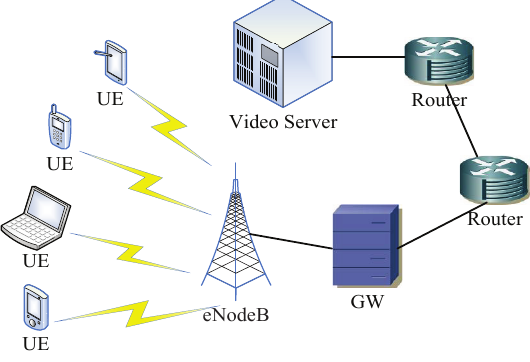
Figure 1: The Topology of the Network Figure 2: The System Block